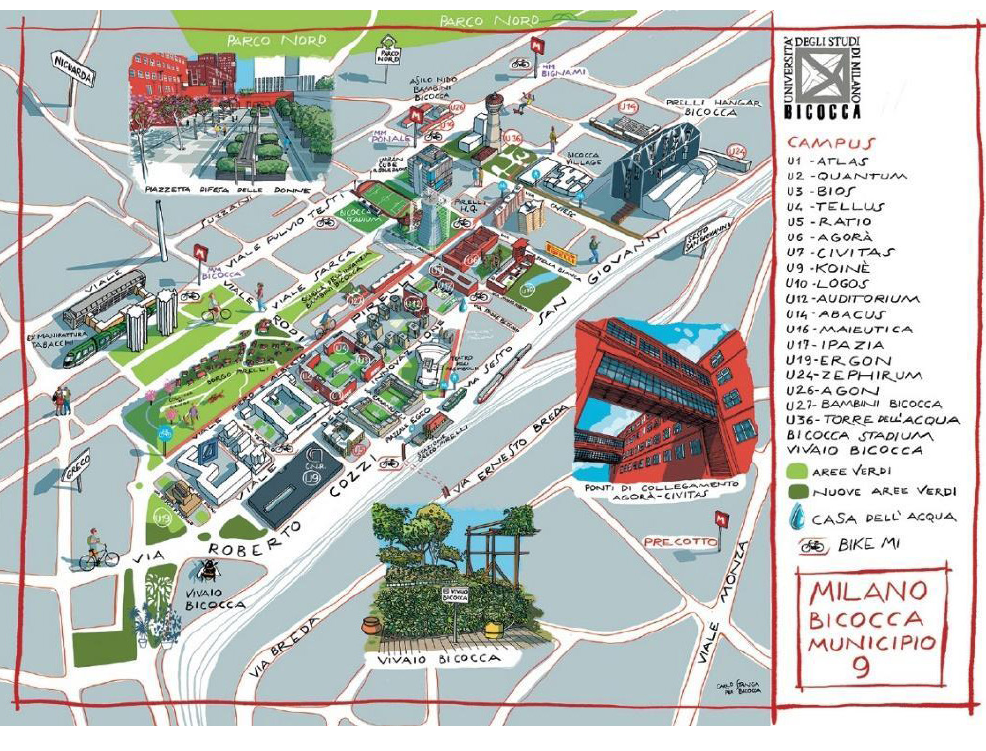
Figure 5 Final Version of